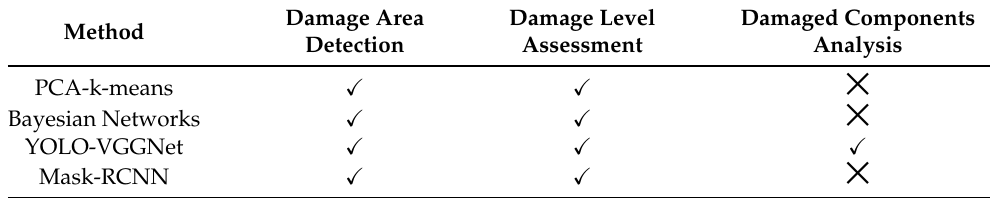
Table 5. The functions of different damage assessment methods.